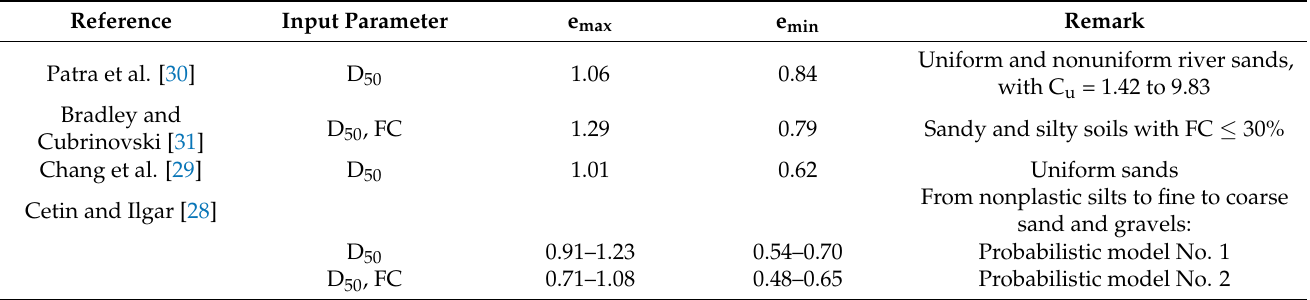
Table 6. Limit index void ratios for the tested sand estimated, as reference, from empirical models reported in the